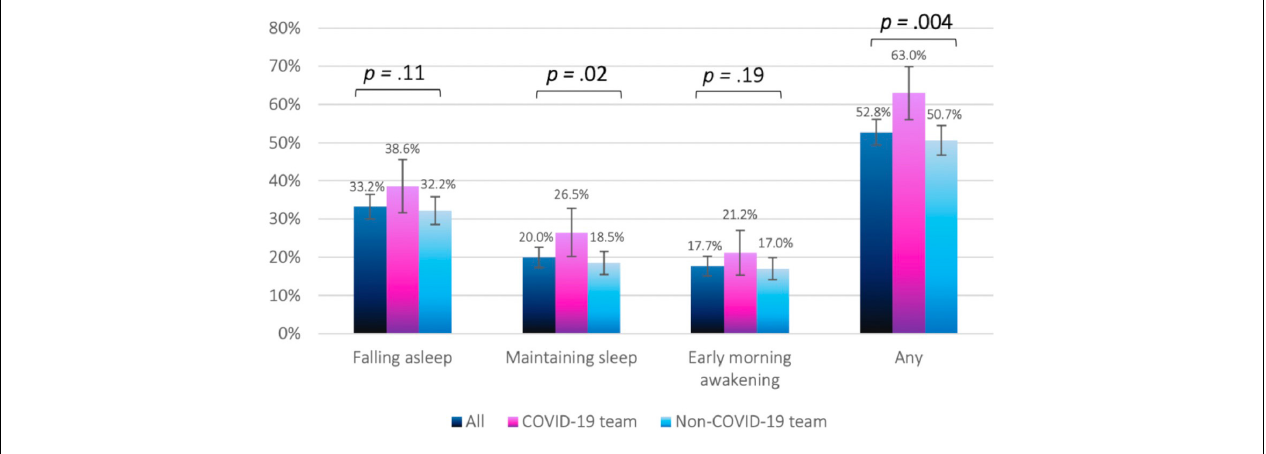
FIGURE 1 | Distribution of sleep difficulties by study